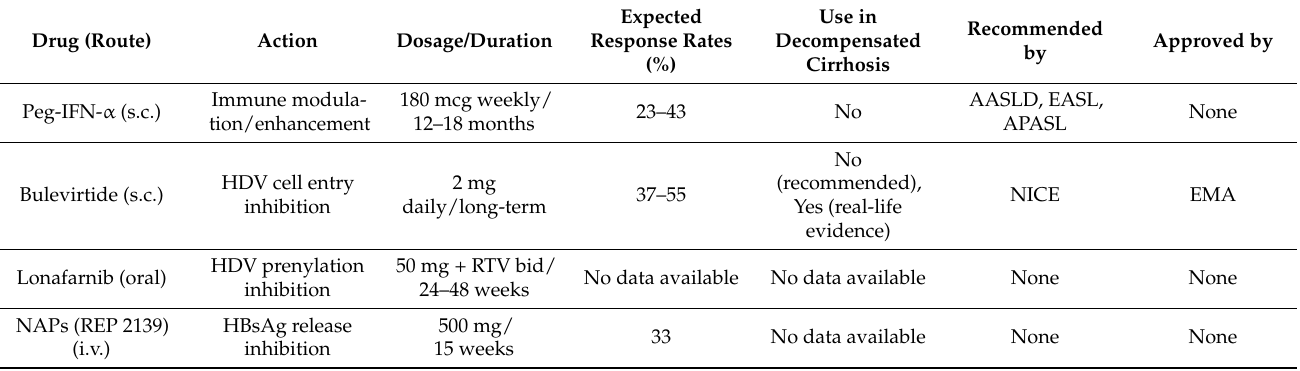
Table 1. Available and experimental drugs for the treatment of Delta hepatitis. Combination therapy trials are underway (Bulevirtide + Peg-IFN- α , Lonafarnib + Peg-IFN- α , NAPs + Peg-IFN- α